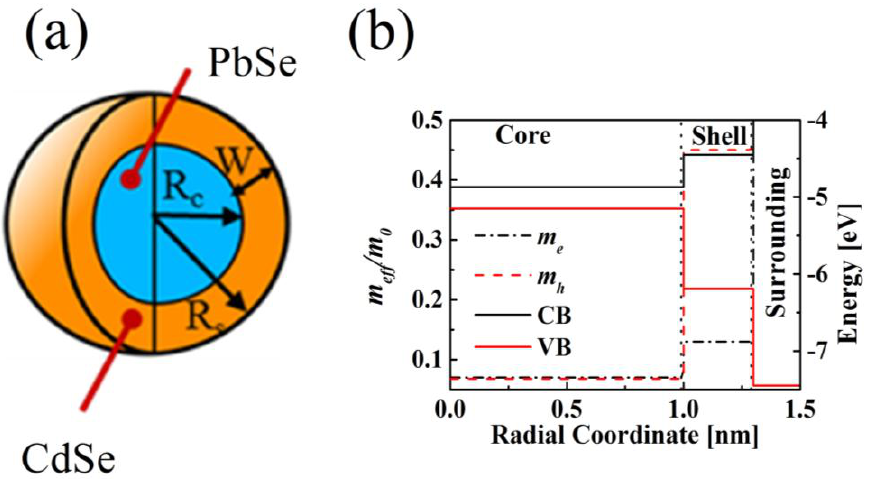
Figure 5. ( b ) Dependencies of the energy bands (VB, CB) and electron and hole effective mass ( m e and m h , respectively) values versus radial coordinate in the PbSe/CdSe QD schematically represented in ( a